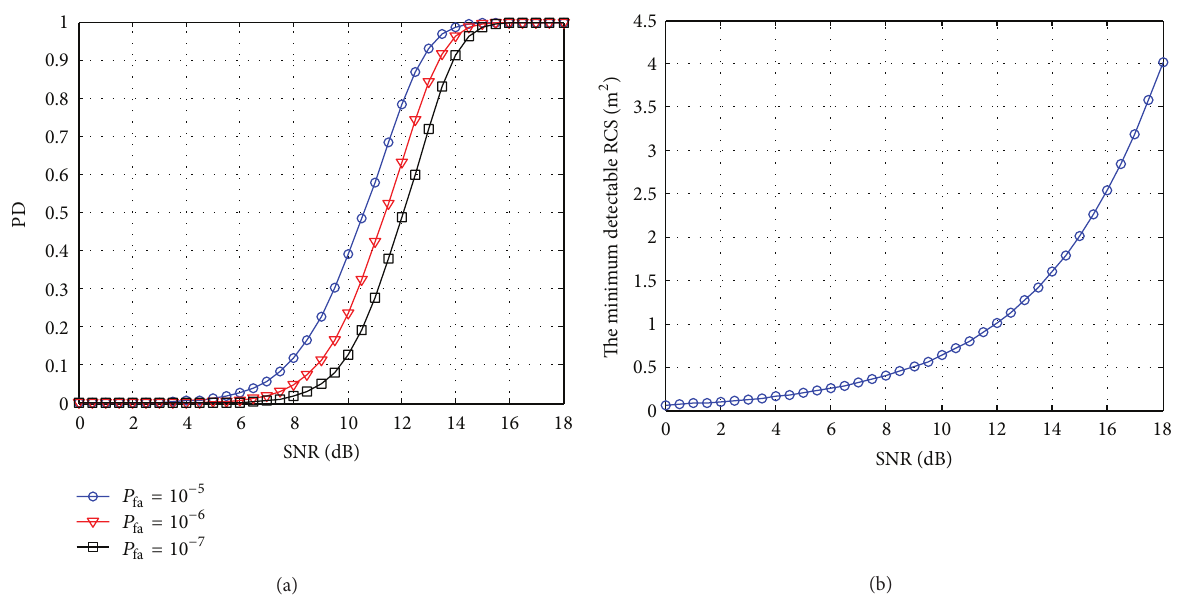
Figure 7: The detection probability (a) and minimum detectable radar cross section (b) as functions of SNR.